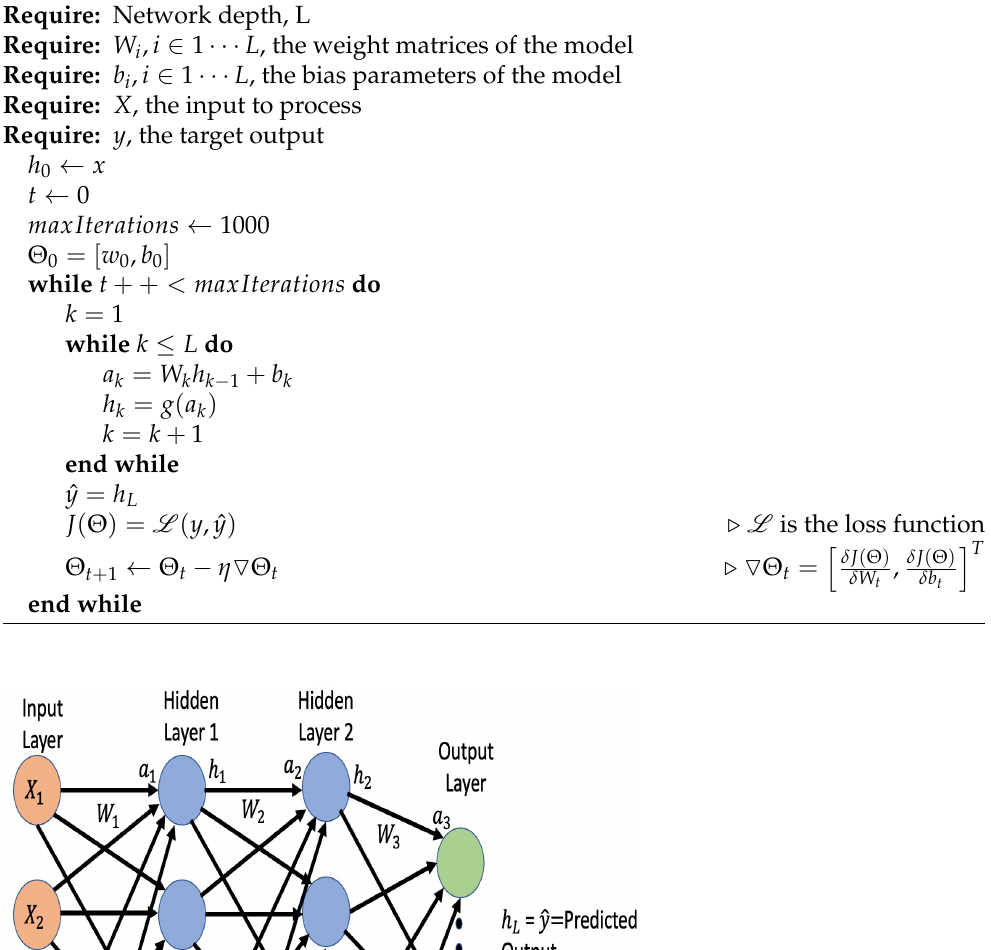
Algorithm 1 Deep Learning Algorithm Forward Propagation Along With Gradient Descent.